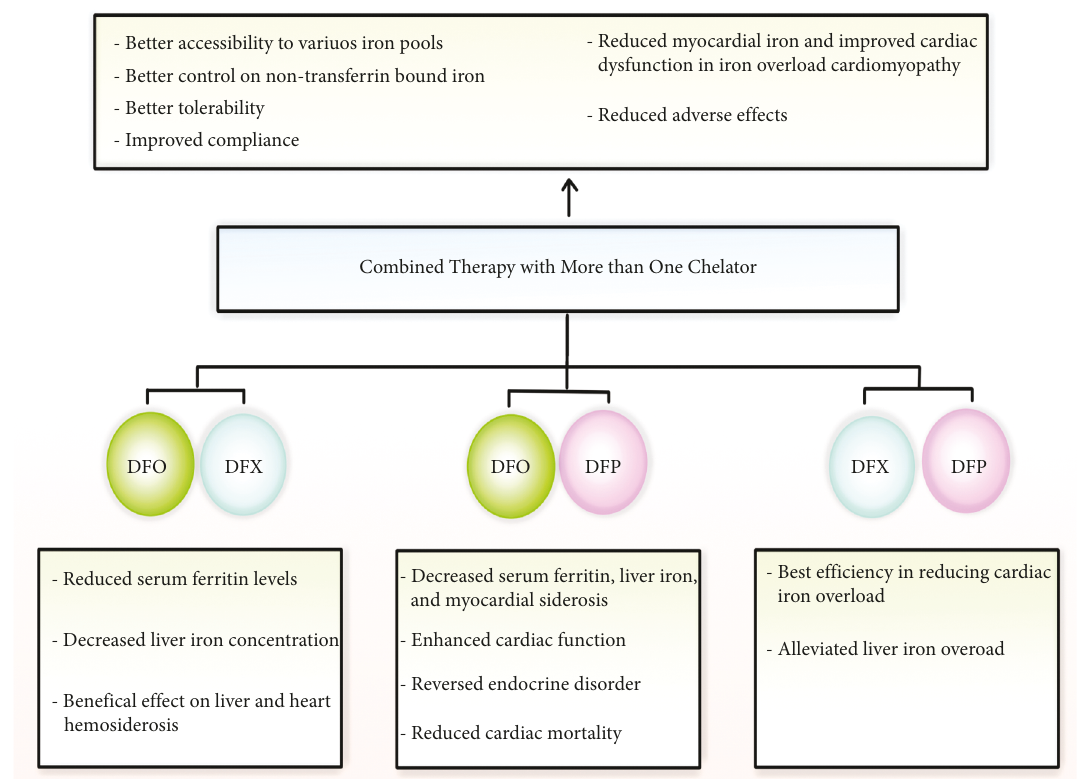
Figure 3: Combination therapy with deferoxamine, deferiprone, and